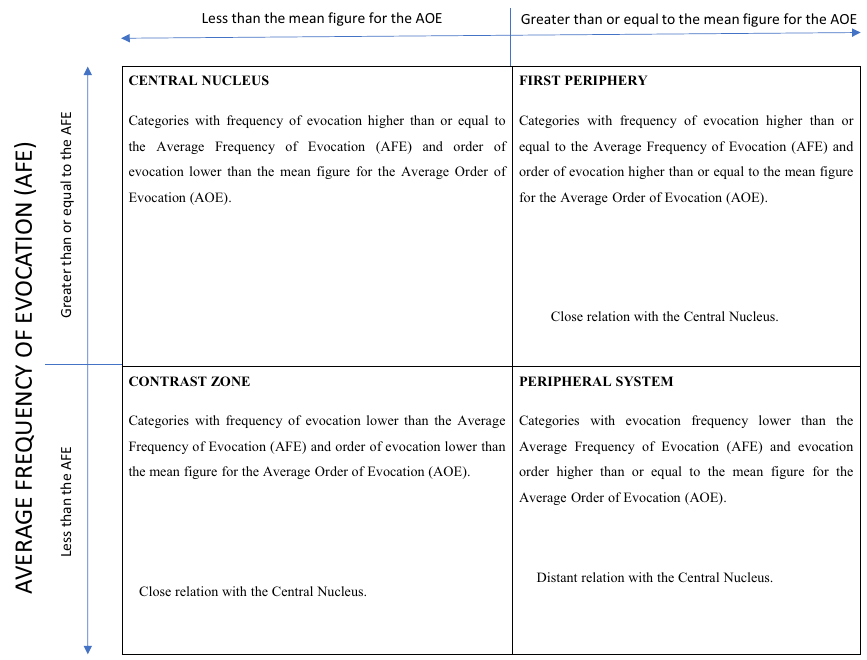
Fig. 1 Vergès’ four-quadrant framework. Source: Adapted from Joia and Correia (2018a, p.